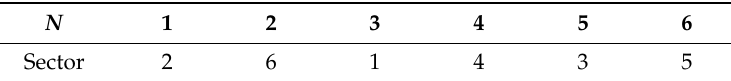
Table 4. Relationship between N and the